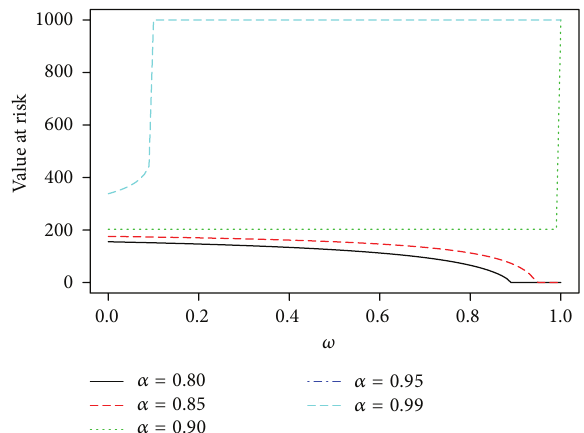
Figure 1: The cumulative distribution functions of 𝑆 20 , for a scale of limiting correlations, 𝜔 , under the 𝛽 -ICM model.